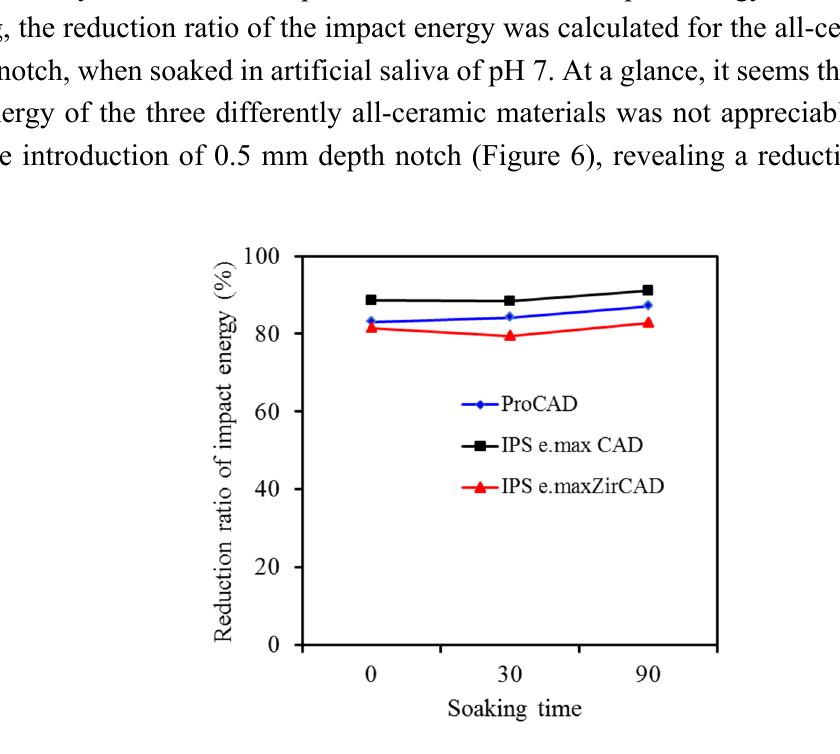
Figure 6. Effect of the preformed notch on reduction of impact energy of ProCAD, IPS e.max CAD and IPS e.max ZirCAD after soaking in pH 7 artificial